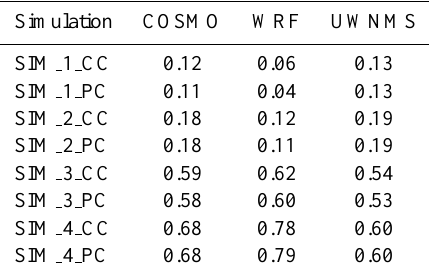
Table 6. Inter-model comparison of the drying ratio for the set of simulations in Table 2. The drying ratio is defined as the ratio of horizontally integrated total precipitation flux at the surface to the vertically integrated water vapour